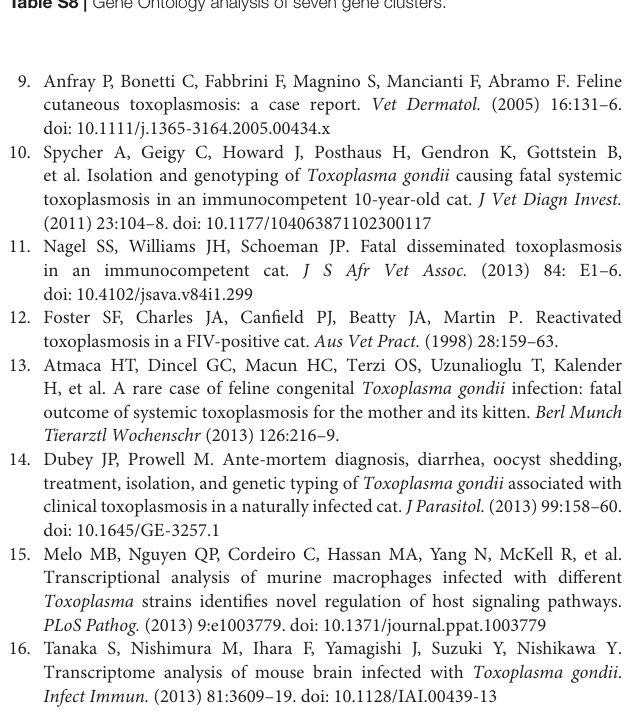
Figure S2 | Differential gene expression patterns across tissues and GO terms of the overlapping DEGs. (A) A heatmap of the genes expressed in all six tissues. (B) Gene Ontology terms associated with the co-expressed DEGs. Figure S3 | Gene Ontology terms and KEGG pathways distribution per gene cluster. Table S1 | Summary of RNA-Sequencing data obtained by Illumina HiSeq 2500 platform. Table S2 | Summary of read mapping. Table S3 | The number of gene in different expression level intervals. Table S4 | Differentially expressed genes in various cat tissues. Table S5 | Functional enrichment analysis of DEGs in various cat tissues. Table S6 | DEGs involved in immune-related pathways in cat tissues. Table S7 | Differentially co-expressed genes across various cat tissues. Table S8 | Gene Ontology analysis of seven gene